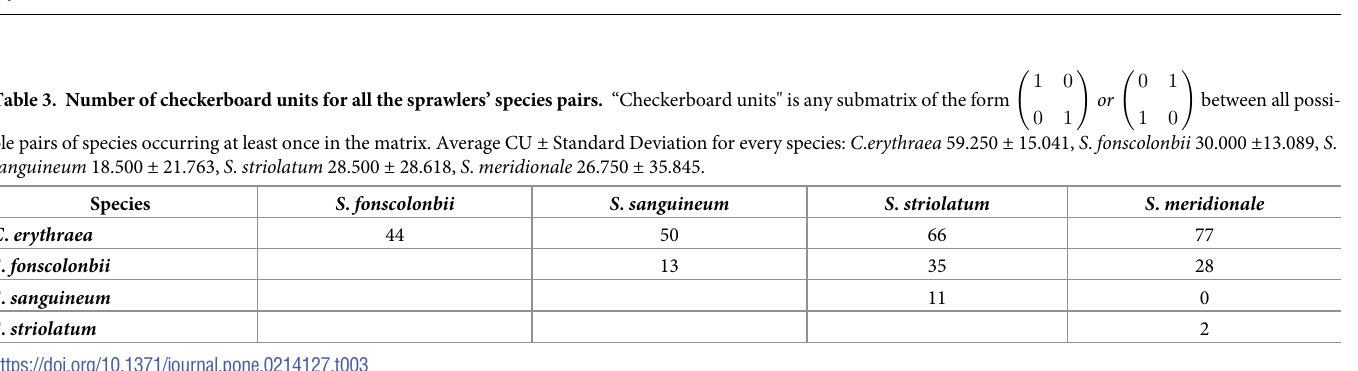
Table 3. Number of checkerboard units for all the sprawlers’ species pairs. “Checkerboard units" is any submatrix of the form